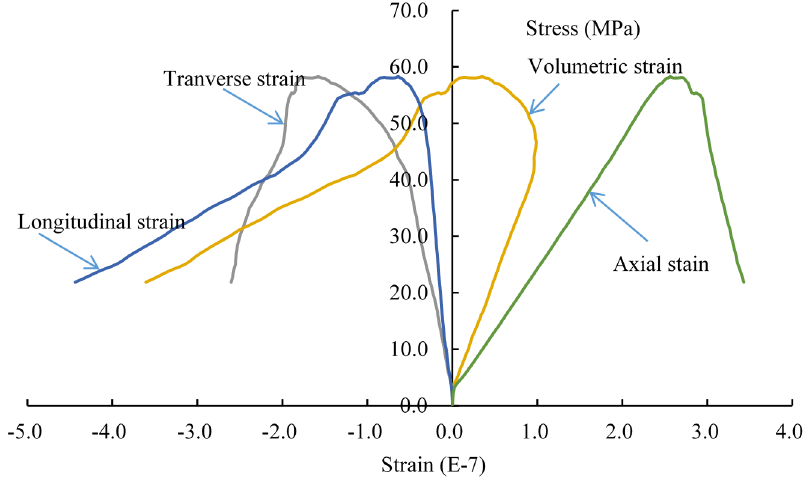
Figure 8. The complete stress-strain curve of the double-fissured specimen under uniaxial compression without fissure water